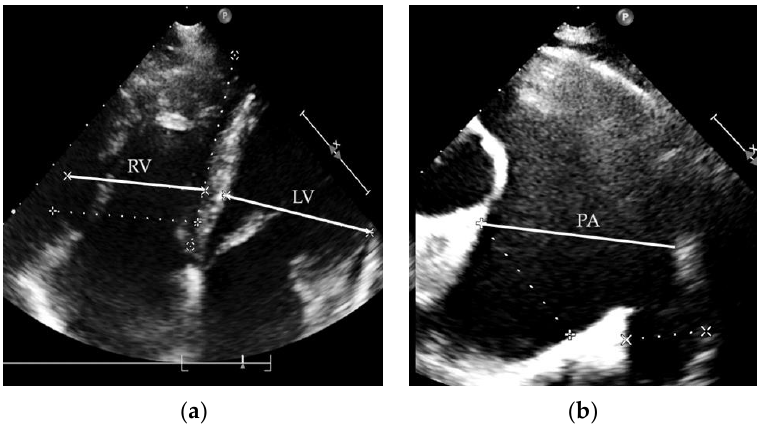
Figure 2. Patient 1 echocardiogram: ( a ) dilated right ventricle; ( b ) dilated pulmonary artery. RV—right ventricle; LV—left ventricle; PA—pulmonary artery.